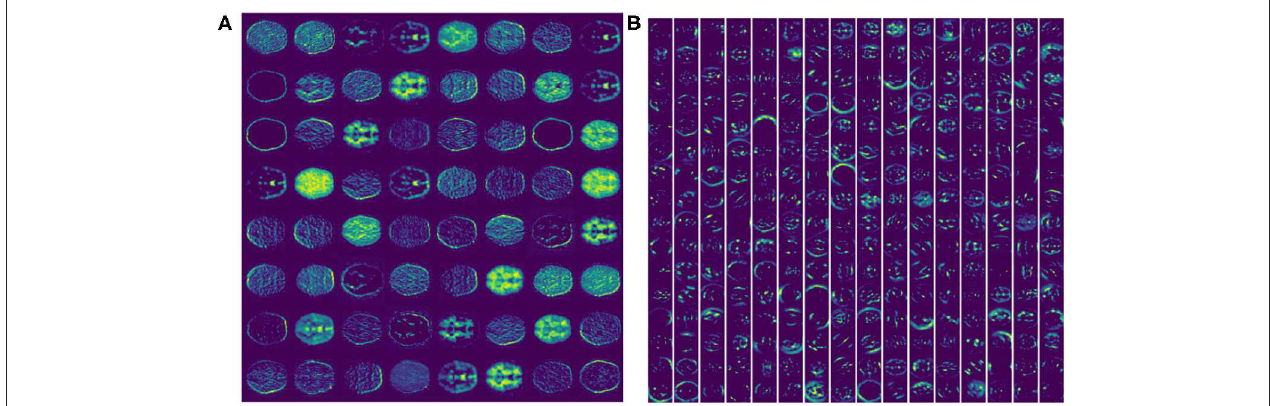
FIGURE 3 | The feature activation maps of an RGB slice in the VGG16 model were visualized. (A) A total of 64 feature maps of 55 × 55 pixels from the first Maxpooling layer. (B) A total of 256 feature maps of 27 × 27 pixels from the seventh CONV layer.